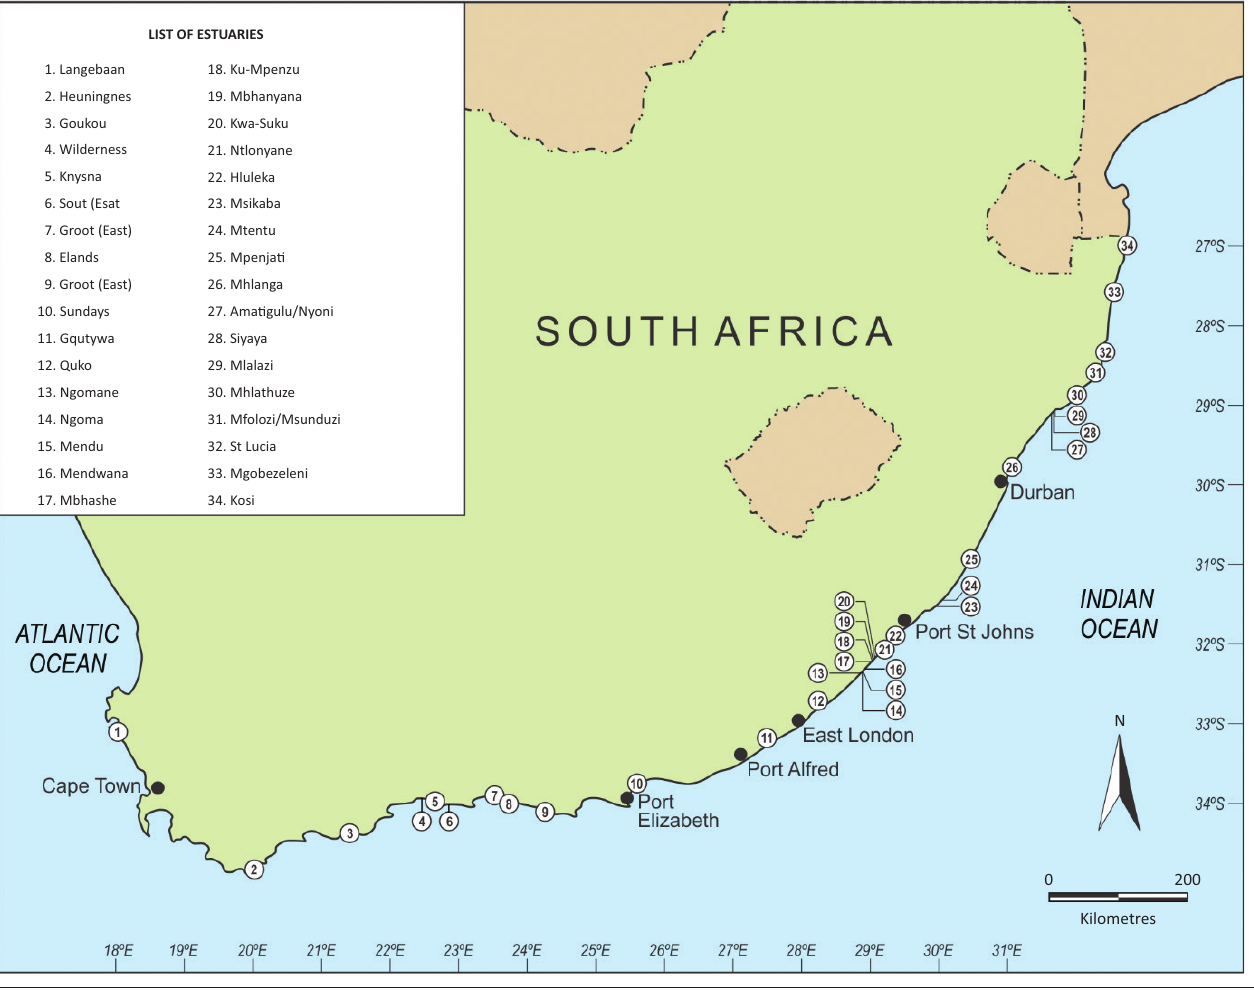
FIGURE 1: Important South African functional estuaries (from a fish diversity and production perspective) that have a formally declared conservation status, even though fish stocks within these areas are often not protected from fishing activities. Very small protected estuaries and those larger systems that have only a minor portion of the water area conserved are not